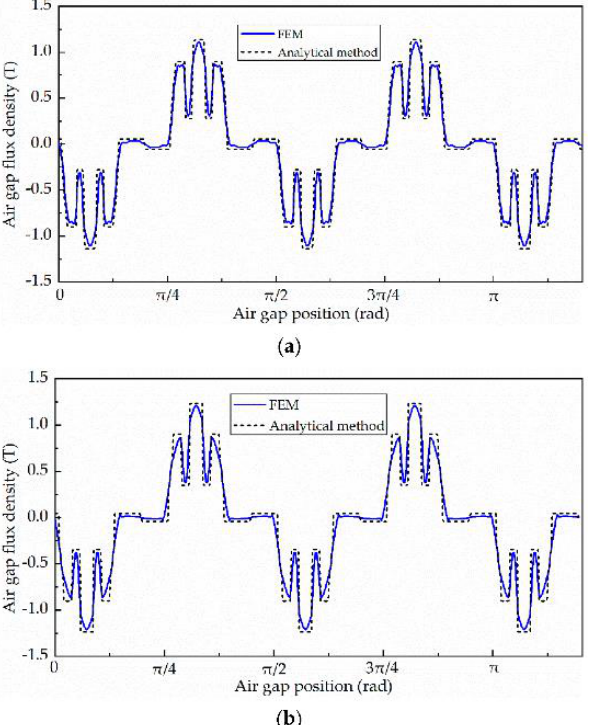
Figure 1. Presented in [2] as Figure 9. The analysis and simulation results for the air-gap flux density: ( a ) dual-V-type motor; ( b ) dual-V-type motor with non-arc pole shoes.